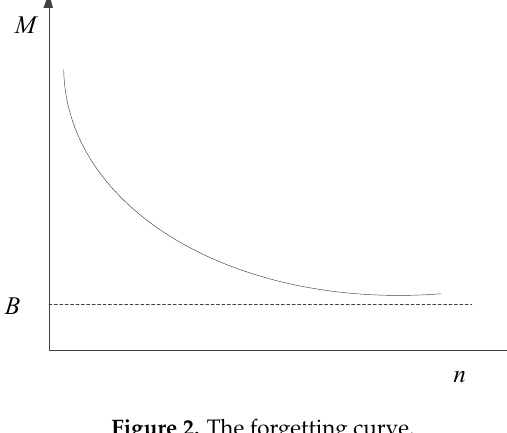
Figure 2. The forgetting curve.